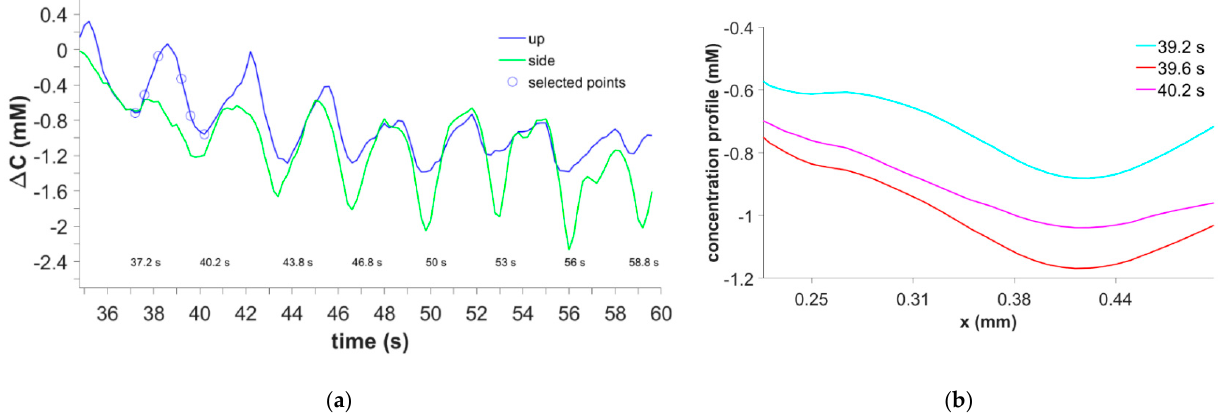
Figure 6. ( a ) Oscillations in the concentration variation for J = 8 mA/cm 2 , averaged in the two ROIs marked as black rectangles in Figure 7. ( b ) Concentration variation profile along the black line marked in Figure 7.